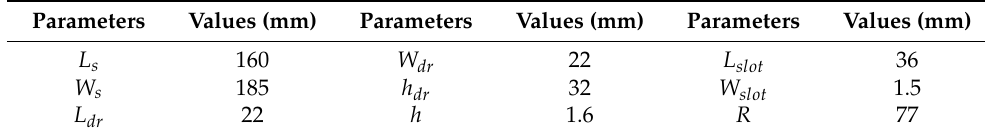
Figure 3. Simulated results of the feeding network. ( a ) Phase shifts between the elements; ( b ) amplitude. Table 1. The dimensions of the proposed DRA.